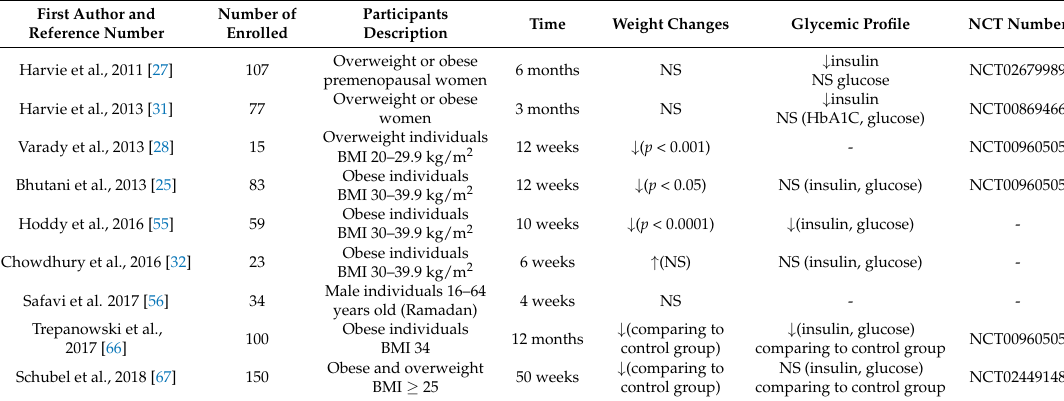
Table 5. The impact of intermittent fasting on obesity and glycemic